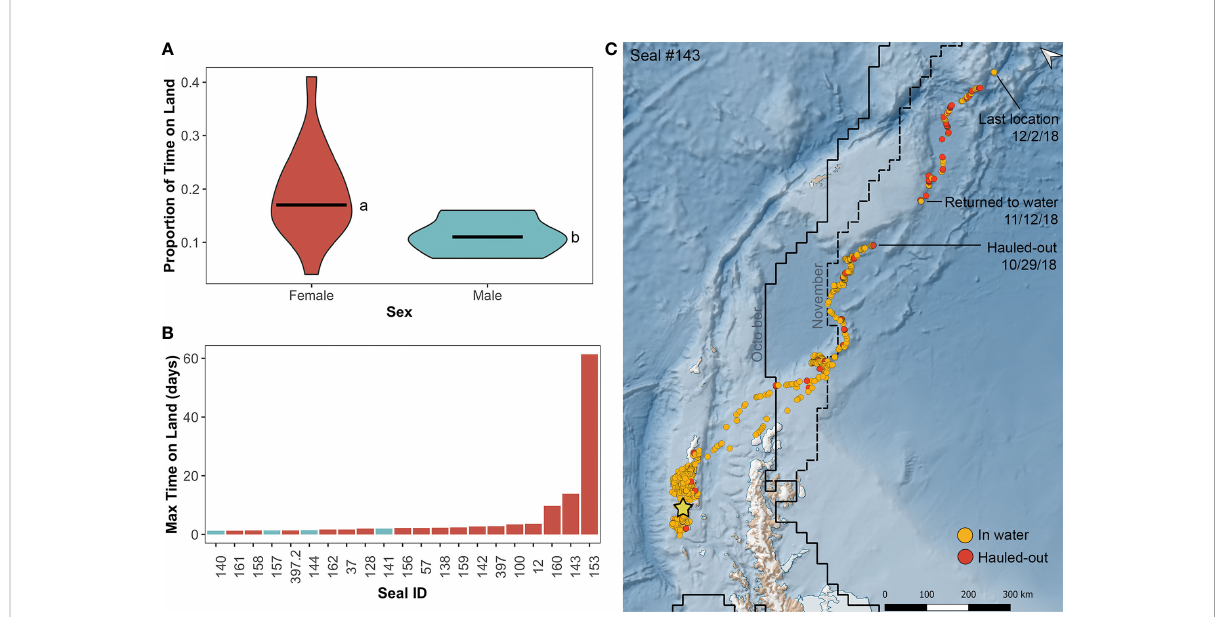
FIGURE 4 Haul-out behavior of leopard seals instrumented at Cape Shirreff. (A) Violin plot comparing sex-speci fi c differences in proportion of time spent on land, where females (red-orange) spend signi fi cantly more time hauled-out than males (blue-gray; a, b; t 11.4 = 2.87, p=0.015). Horizontal bars represent the 25 th , 50 th (median), and 75 th quartiles. (B) Bar graph of maximum time spent on land (days) for each seal color coded by sex. (C) Satellite track of the adult female seal (#143) that hauled-out for 14 days between October 29 and November 12, 2018. Orange circles represent at-sea locations, and red points represent hauled-out locations. The straight black line shows the mean ice extent for October 2018, and the dashed line shows the mean ice extent for November 2018; data were downloaded from the National Snow and Ice Data